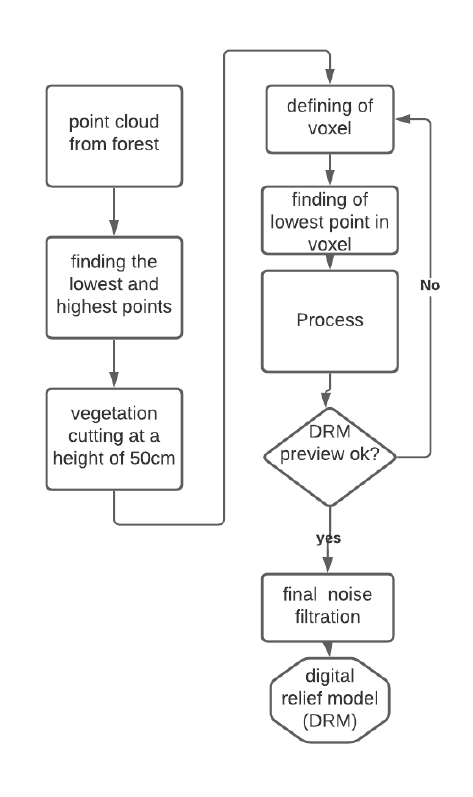
Figure 16. VegRem flowchart